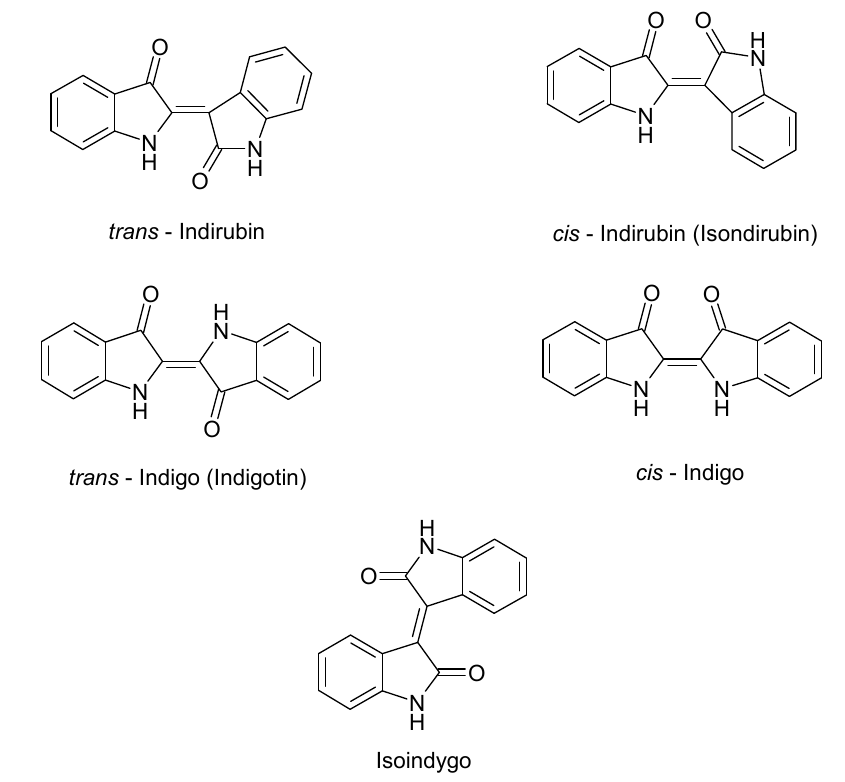
Figure 3. Chemical structure of indigo dyes.